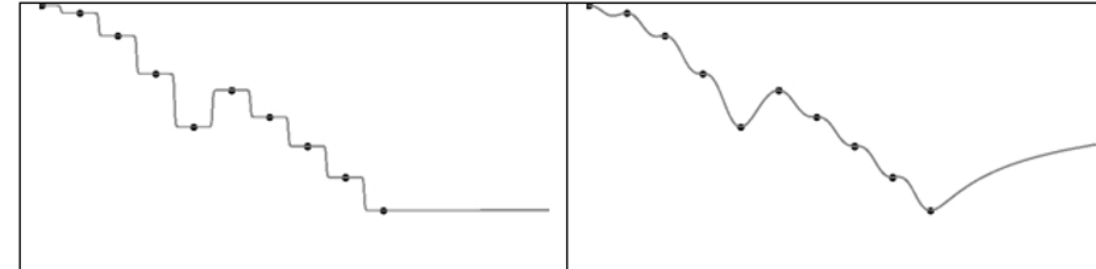
Figure 2. Regression with kernel K